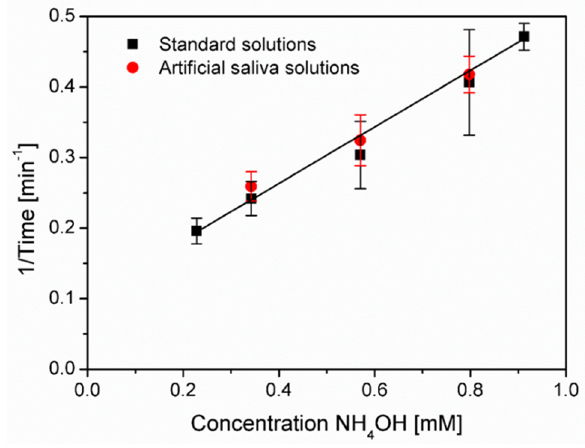
Figure 6. Calibration curve for ammonia sensing in standard and artificial saliva solutions.